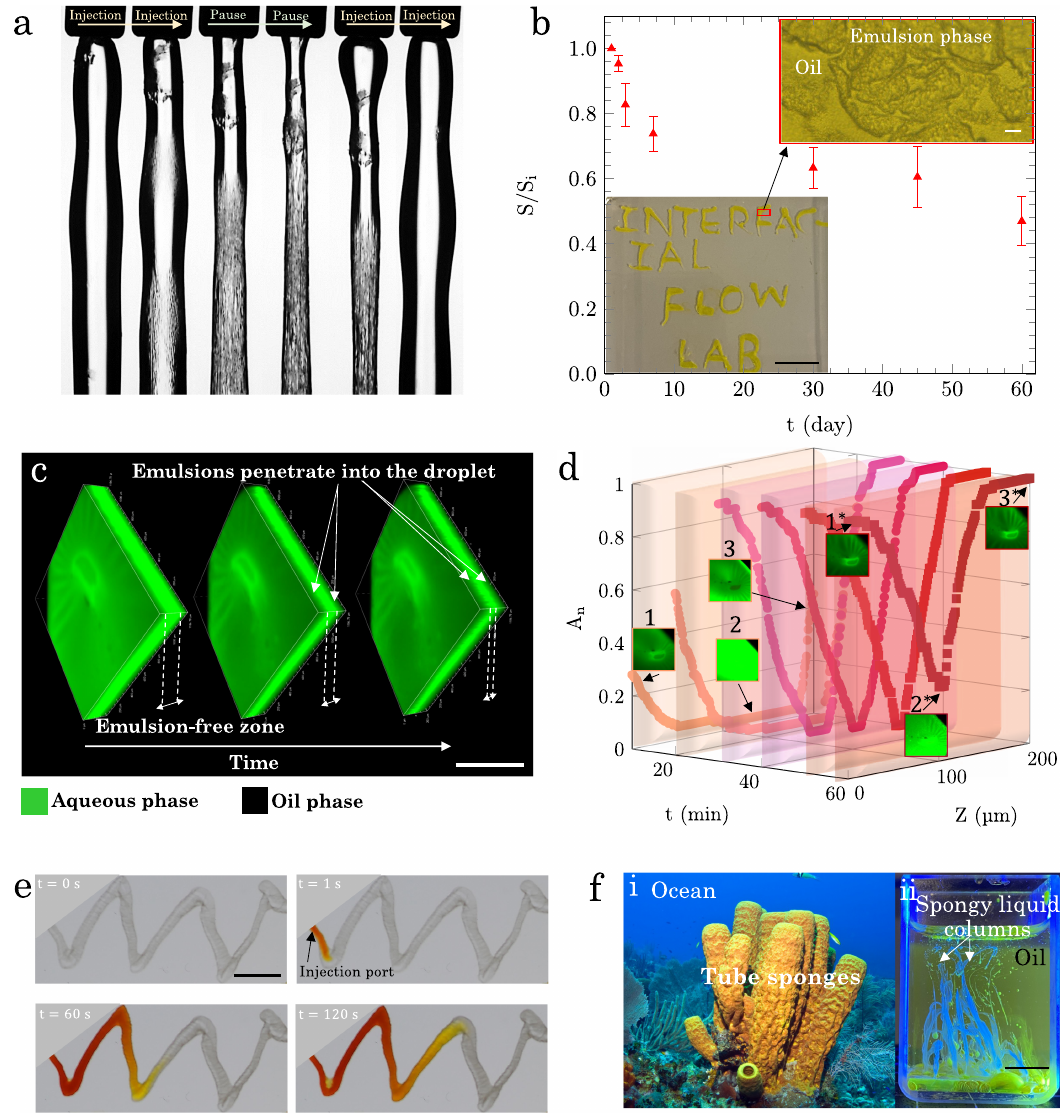
Fig. 4 Applications of stable liquid fi laments. a The stability of a liquid column during the injection-pause cycles. The outer diameter of the needle is 500 μ m. b Printing liquid letters and their stability over two months. The surface area of each letter (S) is divided by its initial surface area (S i ) and plotted as a function of time. The error bars show the average change in surface area of 20 printed letters. The inset at the bottom shows the printed letters (scale bar is 1 mm) and the one at the top indicates the formation of interconnected structures on the surface of the letters (scale bar is 10 μ m). c 3D confocal images that show the formation of emulsions and their advancement in depth over time for 4.0 wt.% silica dispersion droplet in 20.0 wt.% Span micellar solution. Green and back colors represent silica dispersion and oil phases, respectively. The shade of green-black color indicates formation of emulsions. The scale bar is 500 μ m. d Confocal images are captured from the bottom ( z = 0) to the top ( z = 200 μ m) of the droplet with a resolution of 1 μ m in depth and 2 μ m in the x – y plane at 10 min time intervals. Axes show time intervals, location in z, and surface coverage of the emulsions. The data points at each time interval are represented with a different color to aid the visualization. e Injection of DI water (yellow) into the hand-printed silica dispersion channel. f Similarities between (i) tube sponges in oceans and (ii) spongy liquid columns. The image in (i) is taken from iStock.com/Kevin Panizza. The yellow tube sponge is relatively large and it can grow up to 1 m in length. The scale bar in (ii) represents 1 cm. Source data are provided as a Source Data fi